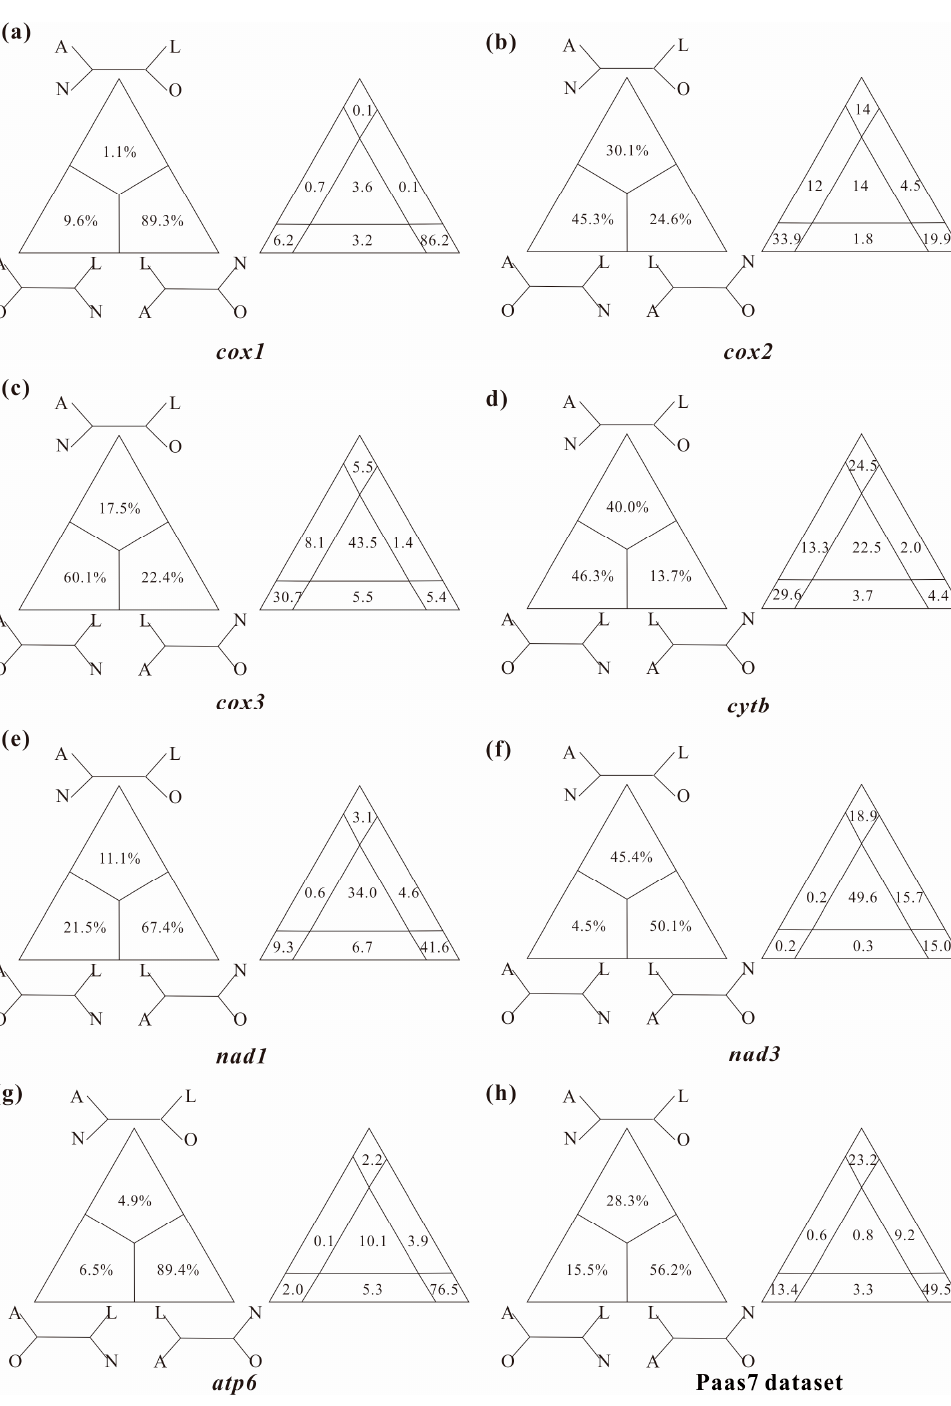
Figure 4. Conflict visualization using four-cluster likelihood mapping analyses as implemented in Treepuzzle based on the amino acid sequences of cox1 ( a ), cox2 ( b ), cox3 ( c ), cytb ( d ), nad1 ( e ), nad3 ( f ), atp6 ( g ), and Paas7 dataset ( h ). Quartet proportions (in %) are mapped on a 2D-simplex graph supporting different quartet topologies on the major phylogenetic relationships within Branchiopoda.